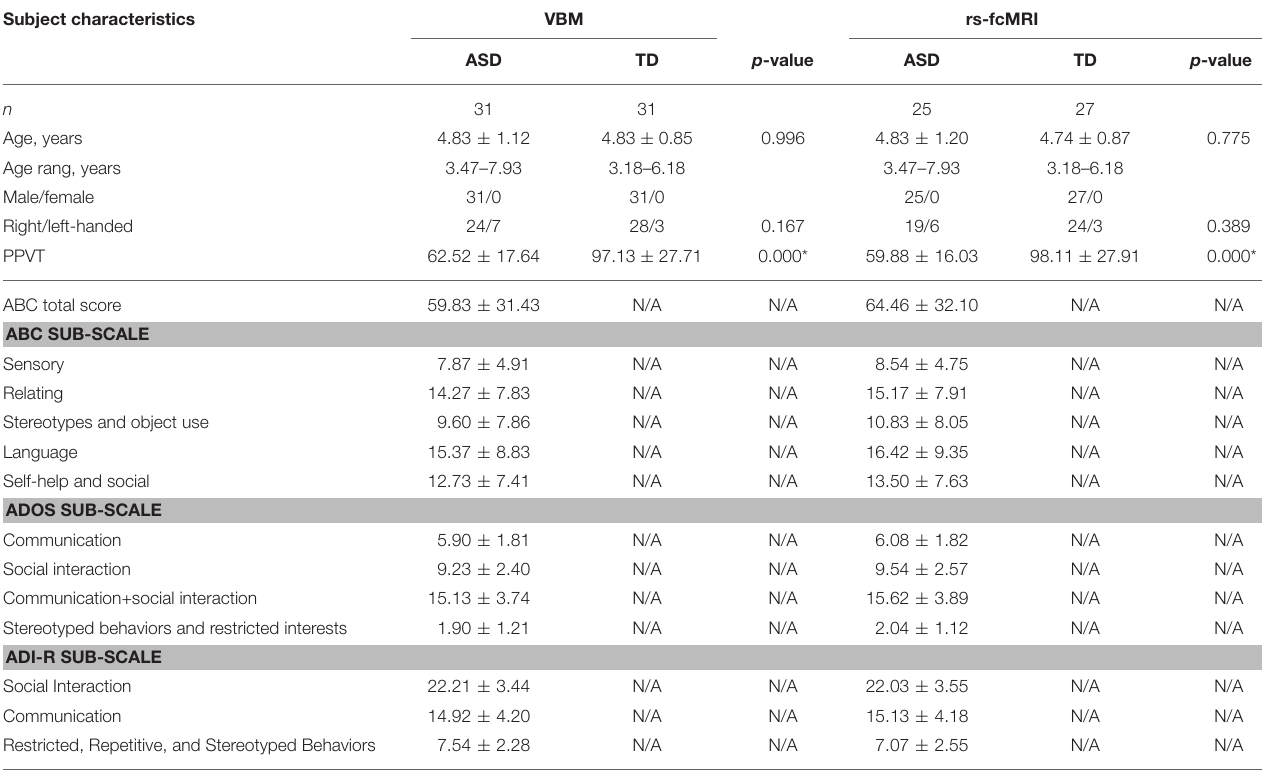
TABLE 1 | Demographic data (means ± SD) of ASD and typically developing